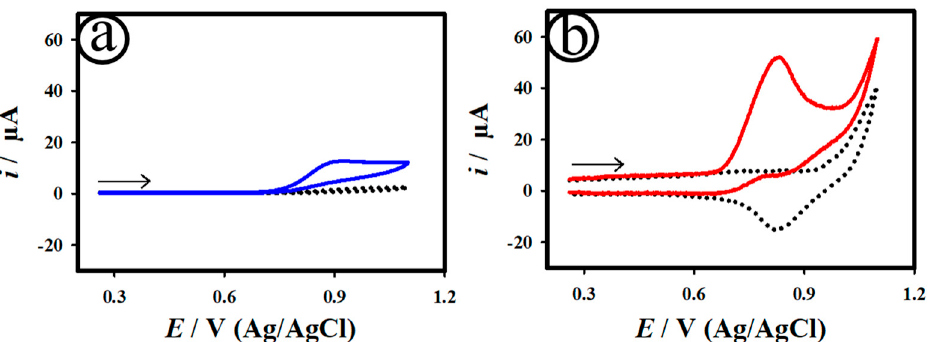
Figure 4. CV curves of the bare CF ( a ) and AuNC@AuDS|CF ( b ) microelectrodes measured in the nonexistence (dotted curve) and existence (solid curve) of 50.0 µ M NO 2 − in 0.1 M PB at a scan rate of 20 mVs − 1 .